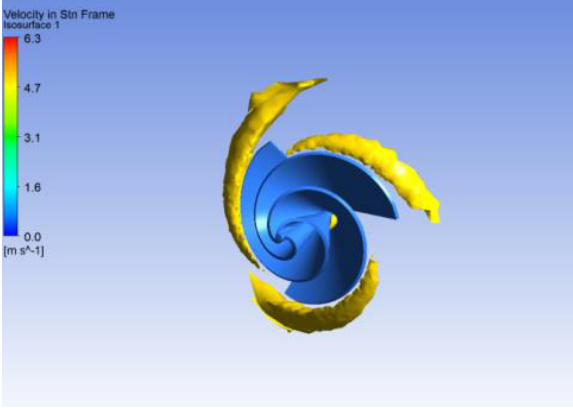
Figure 10. Vortical structures represented by the isosurface of the swirl strength (unsteady simulation, 5.0 m/s, and 500